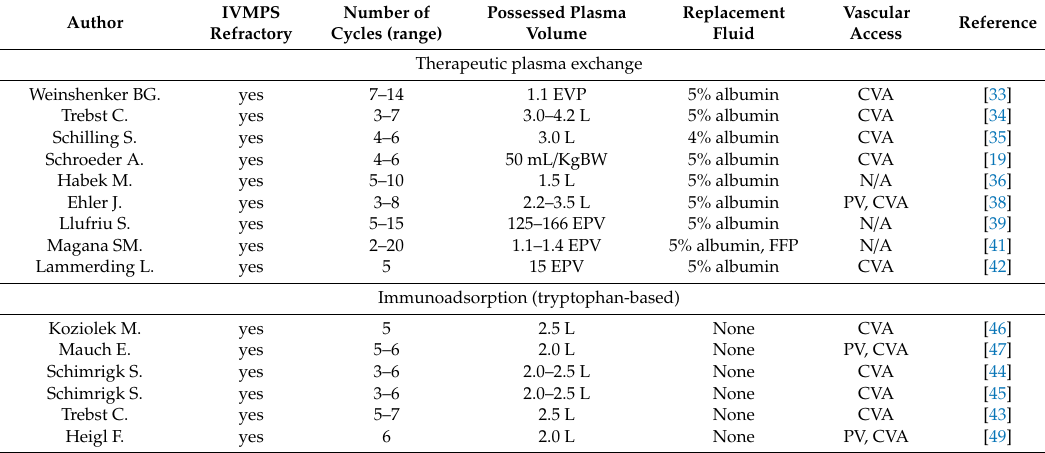
Table 3. Overview of technical details on therapeutic plasma exchange (TPE) and immunoadsorption (IA )in acute MS